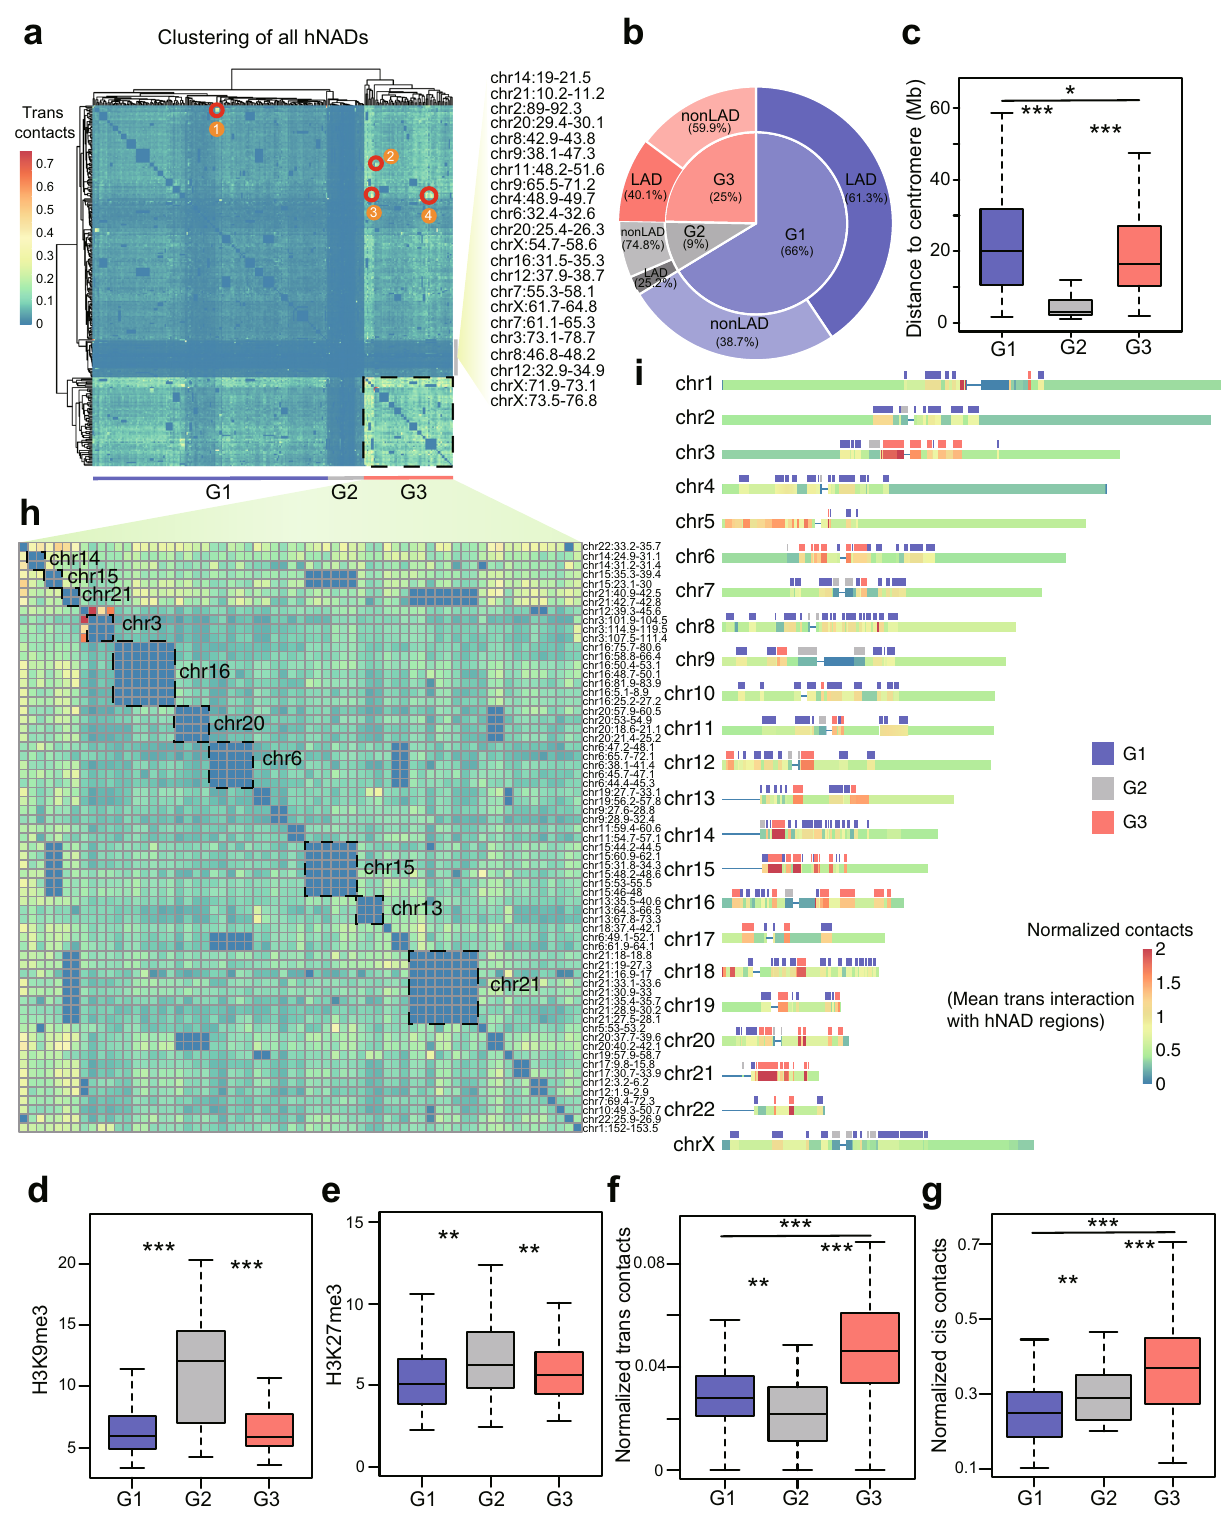
Fig. 4 | Global properties of hNAD inter-chromosomal interactions. a hNAD clustering results basedon hNAD trans interactions captured by nHi-C. Circledout regions are hNAD-involved chromosome translocations. b Percentage of G1, G2, and G3 hNADs (inner layer) and their overlap percentage with LADs (outer layer). c Distance of G1, G2, and G3 hNADs from centromeres. d – e H3K9me3 ( d ) and H3K27me3 ( e ) signals in G1, G2, and G3hNADs. f , g Trans ( f ) and cis ( g ) interaction levels of G1, G2, and G3 hNADs. h Composition and chromatin interactions of G3